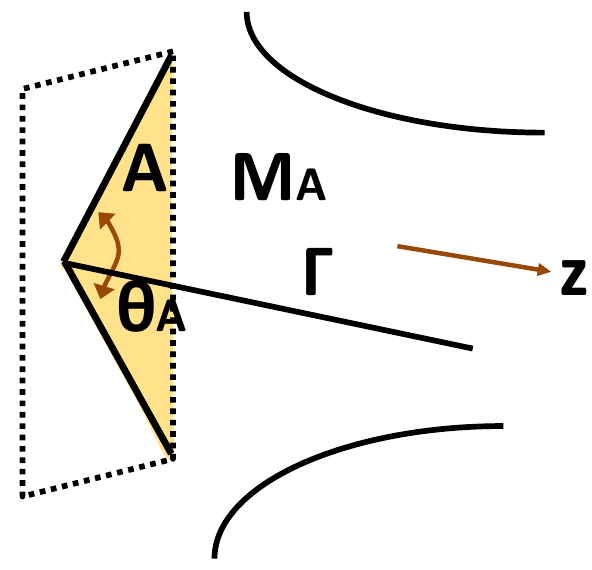
Figure 8 . A gravity dual of a CFT on a wedge in